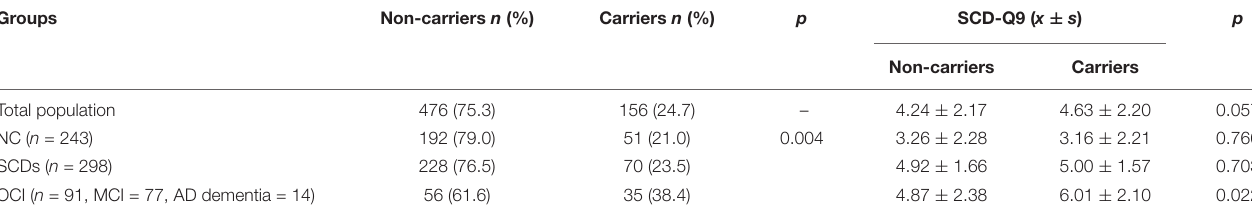
TABLE 3 | Distribution of APOE ε 4 and SCD-Q9 scores of carriers and non-carriers in NC, SCDs, and OCI groups.